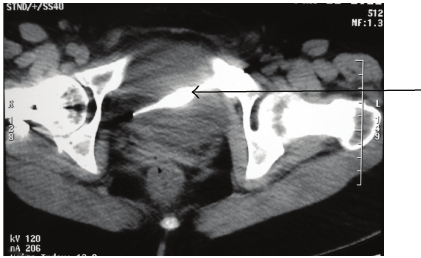
Figure 2: Computed tomography showing K-wire lying in the soft tissues of the